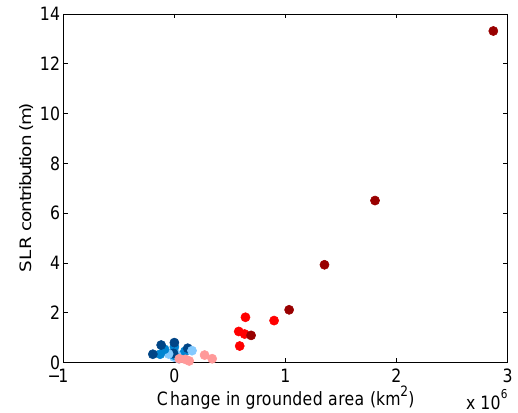
Figure 1. Change in grounded area vs. contribution to SLR after 200 years for all models participating in the SeaRISE Antarctic ex- periments. For reference, a loss of 4.0469 × 10 14 m 3 of ice above flotation equates 1m rise in mean global sea level. Blue shading corresponds to the sliding experiments with increasing darkness re- lated to an increase in forcing (S1, S2 and S3). Similarly, the lightest red to the darkest one corresponds to melting experiments M1, M2 and